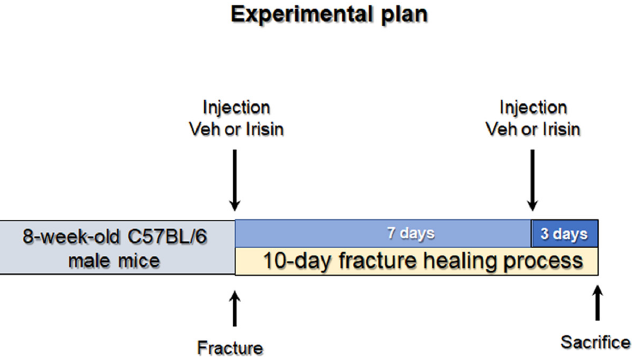
Figure 5. Experimental plan. Eight-week-old C57BL/6 male mice were subjected to closed, transverse, mid-diaphyseal tibial fractures on the right tibia. One group ( n = 6 vehicle) was intra-peritoneally (i.p.) injected with phosphate buffer solution (PBS), and the other group ( n = 6 irisin-treated mice) was injected with 100 mg/kg irisin at days 0 and 7. All mice were sacrificed 10 days post fracture induction.